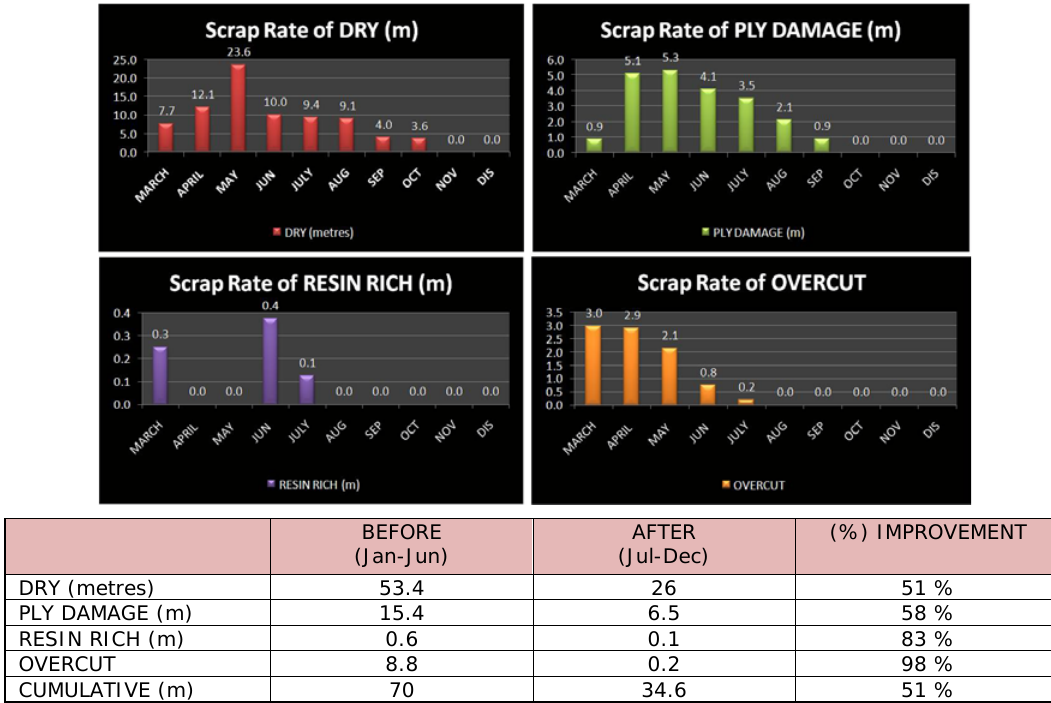
Figure 7. “Overall Scrap Measuring Mechanism